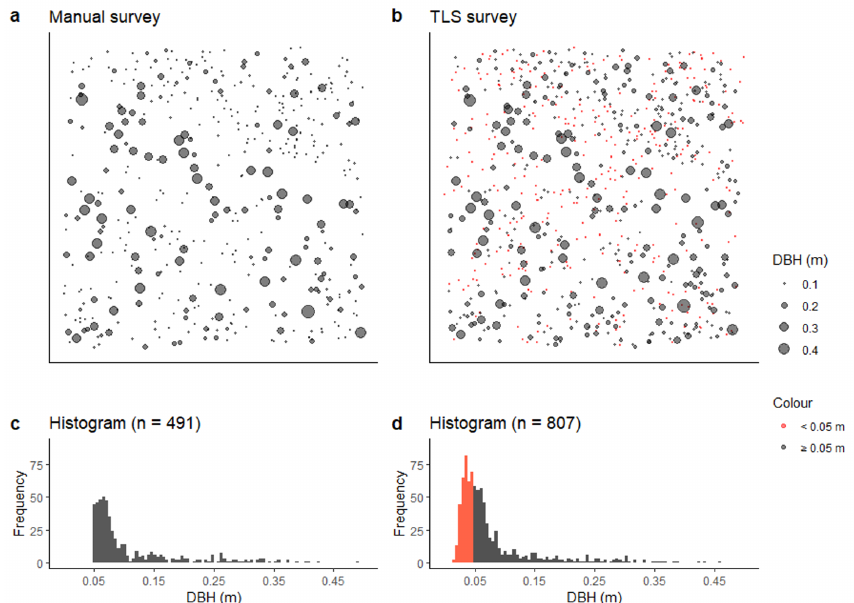
Figure 5. Spatial distribution and number of trees captured in both surveys conducted in August 2018. ( a ) distribution map of field survey; ( b ) distribution map of terrestrial laser scanning (TLS) survey, red denotes trees with stem diameter (DBH) < 0.05 m not captured in the manual survey ( n grey = 449, n red = 358); ( c ) Histogram of field survey; ( d ) Histogram of TLS survey. TLS surveys are able to capture small trees that are impractical to include in manual field